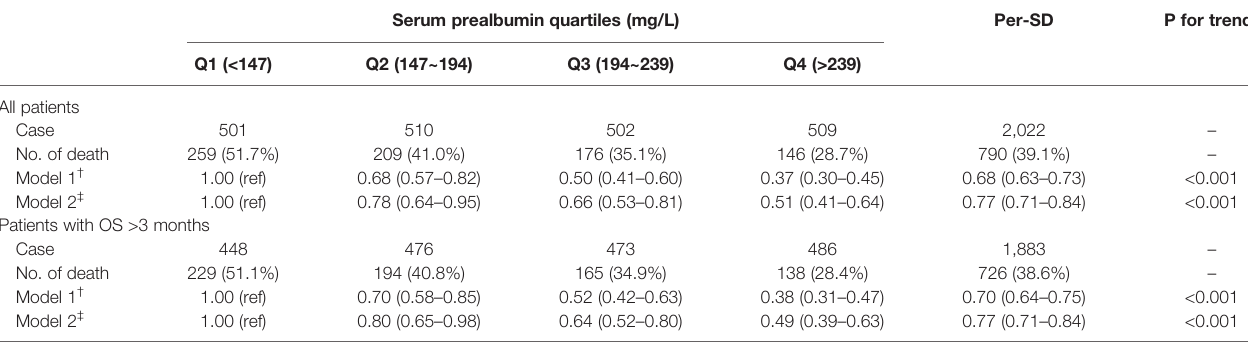
TABLE 3 | Risk of mortality associated with serum